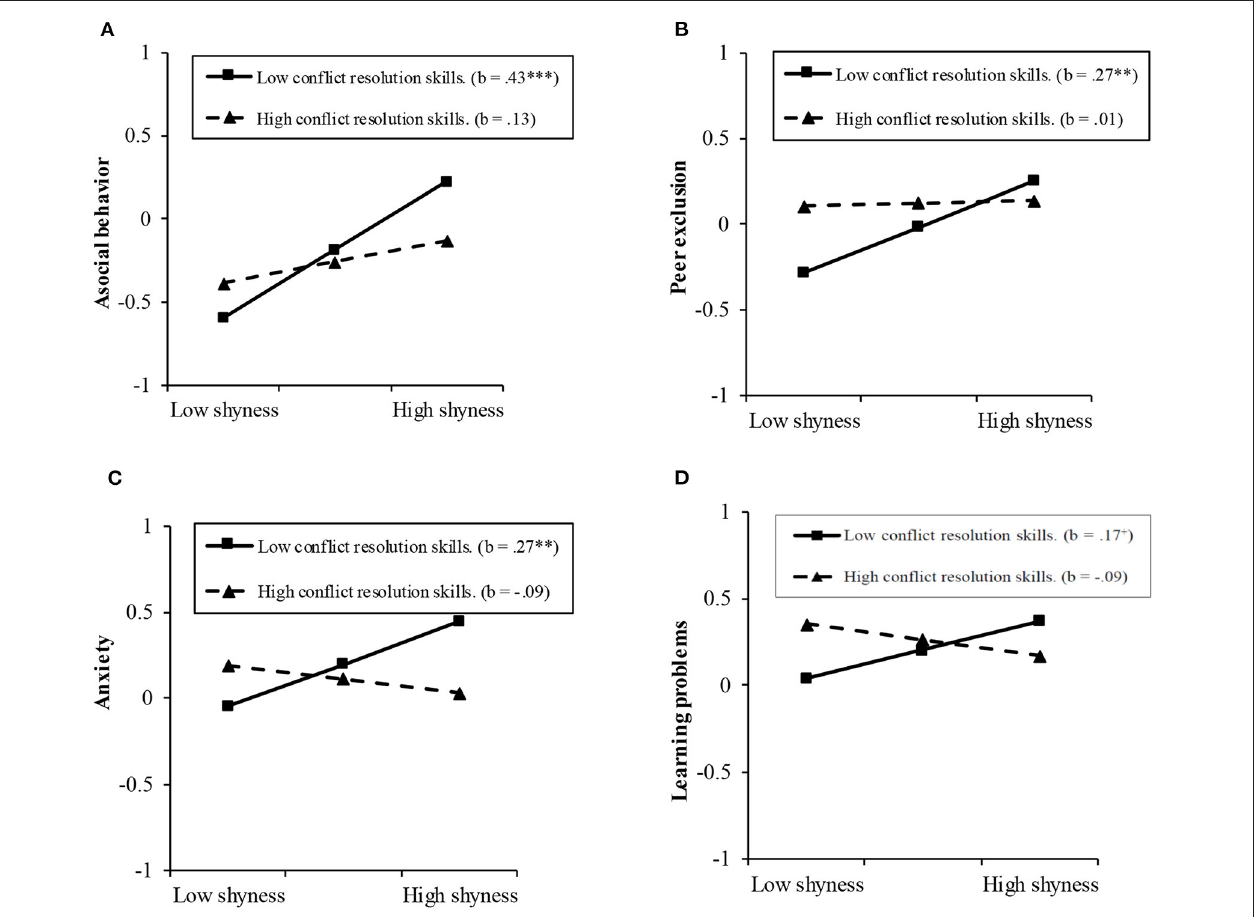
FIGURE 1 | (A) Interaction between shyness and conflict resolution skills in predicting asocial behavior. (B) Interaction between shyness and conflict resolution skills in predicting peer exclusion. (C) Interaction between shyness and conflict resolution skills in predicting anxiety. (D) Interaction between shyness and conflict resolution skills in predicting learning